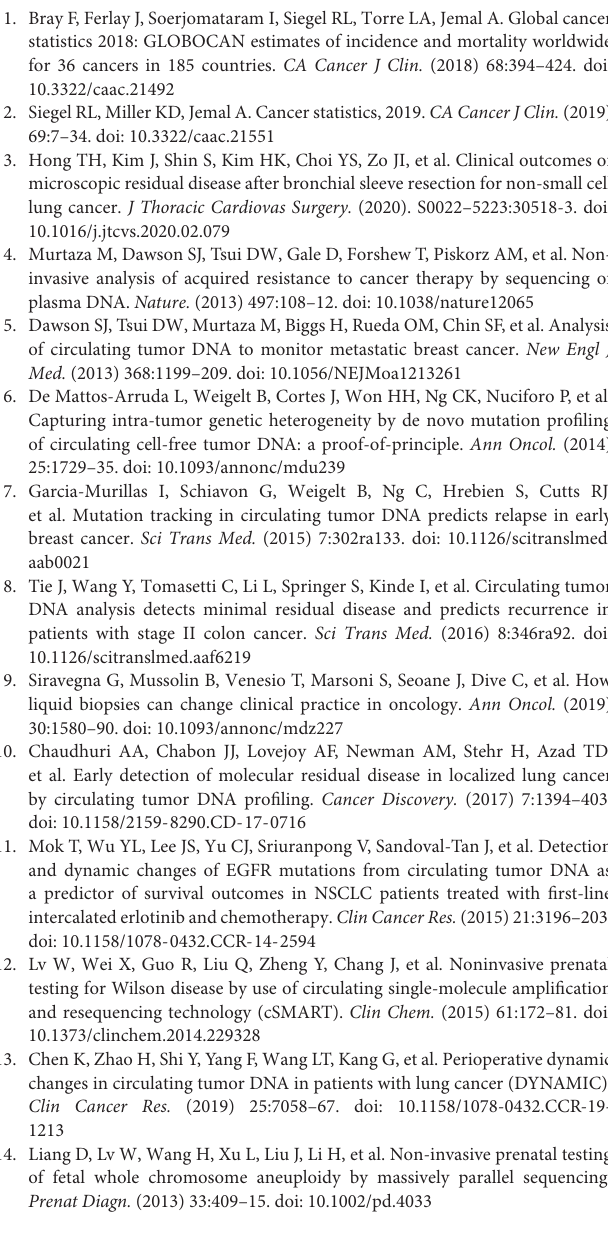
TABLE S3 | Characteristics of all patients. TABLE S4 | Tissue capture results of all 77 patients. TABLE S5 | Recurrence free survival and overall survival for all